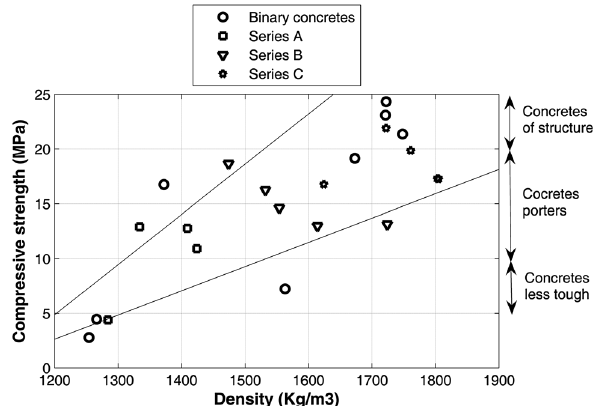
Fig. 7 Compressive strength as a function of